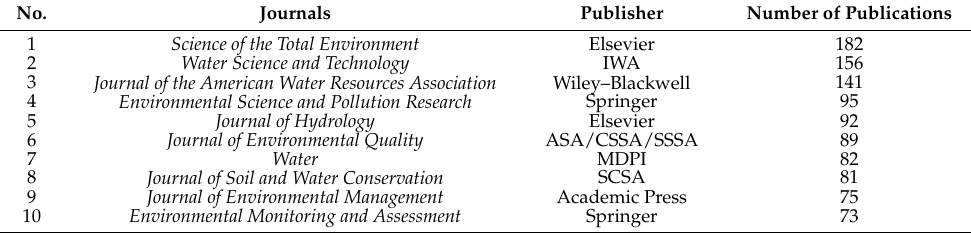
Table 2. Top 10 journals.